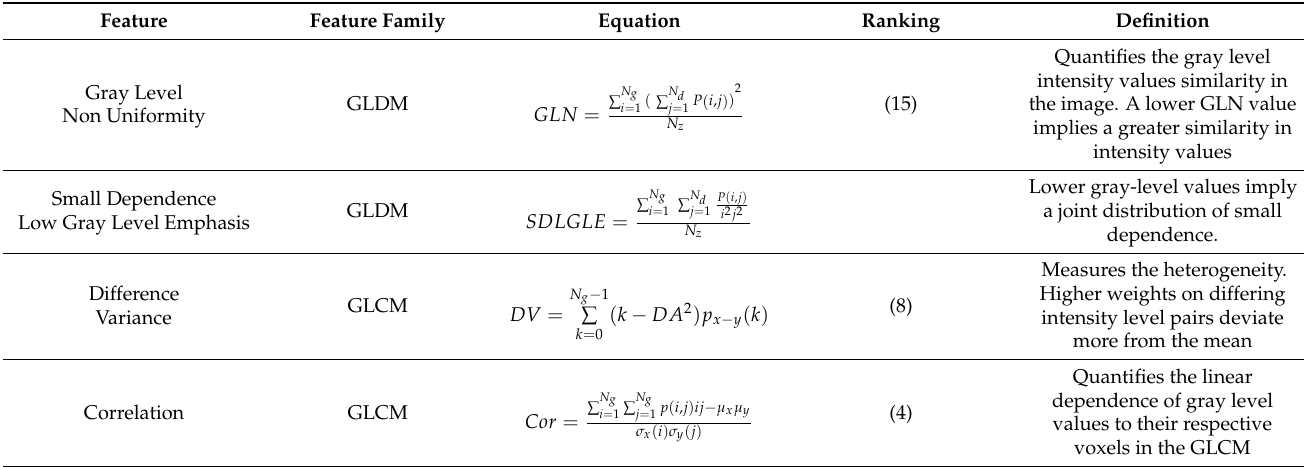
Table 3. The CTV ROI Features Incorporated in the Optimal Classification